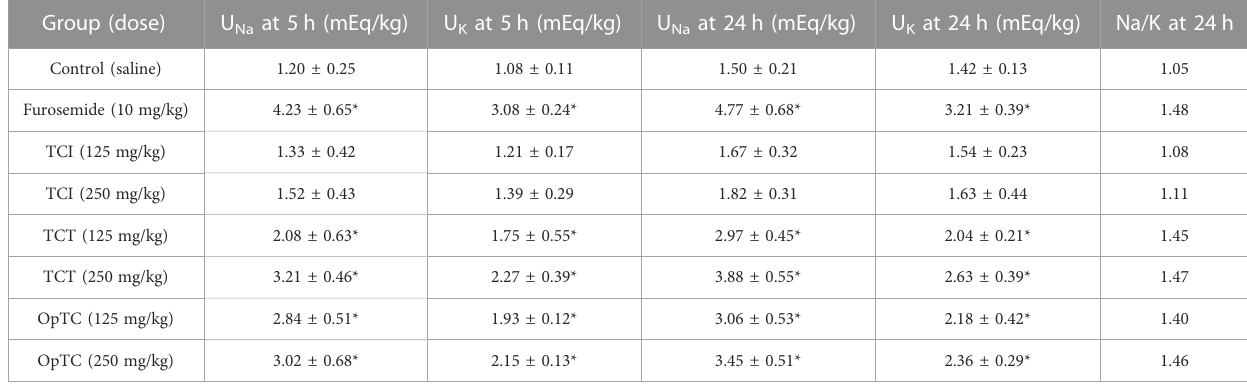
TABLE3Effectoftheherbalpreparationsobtainedfrom Thymuscomosus onurinaryexcretionofsodium(U Na )andpotassium(U K )5hand24 hafterthesubstance administration, and the ratio Na/K in saline loaded Crl:WI rats. Values of U Na V and U K V are expressed as Mean ± SD ( n = 6); (* p < 0.05 vs. saline control).